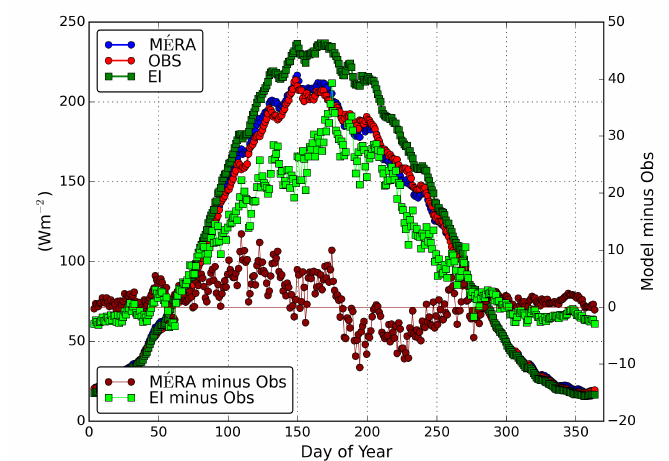
Figure 3. Daily mean GHI, averaged over the seven original stations in the Irish network: observed (red), MÉRA(blue) and ERA-Interim (dark green) SW irradiances are shown as a function of day of the year using data for years 1981 to 2015. The biases in MÉRA (maroon) and ERA-Interim (light green) compared to observations are also